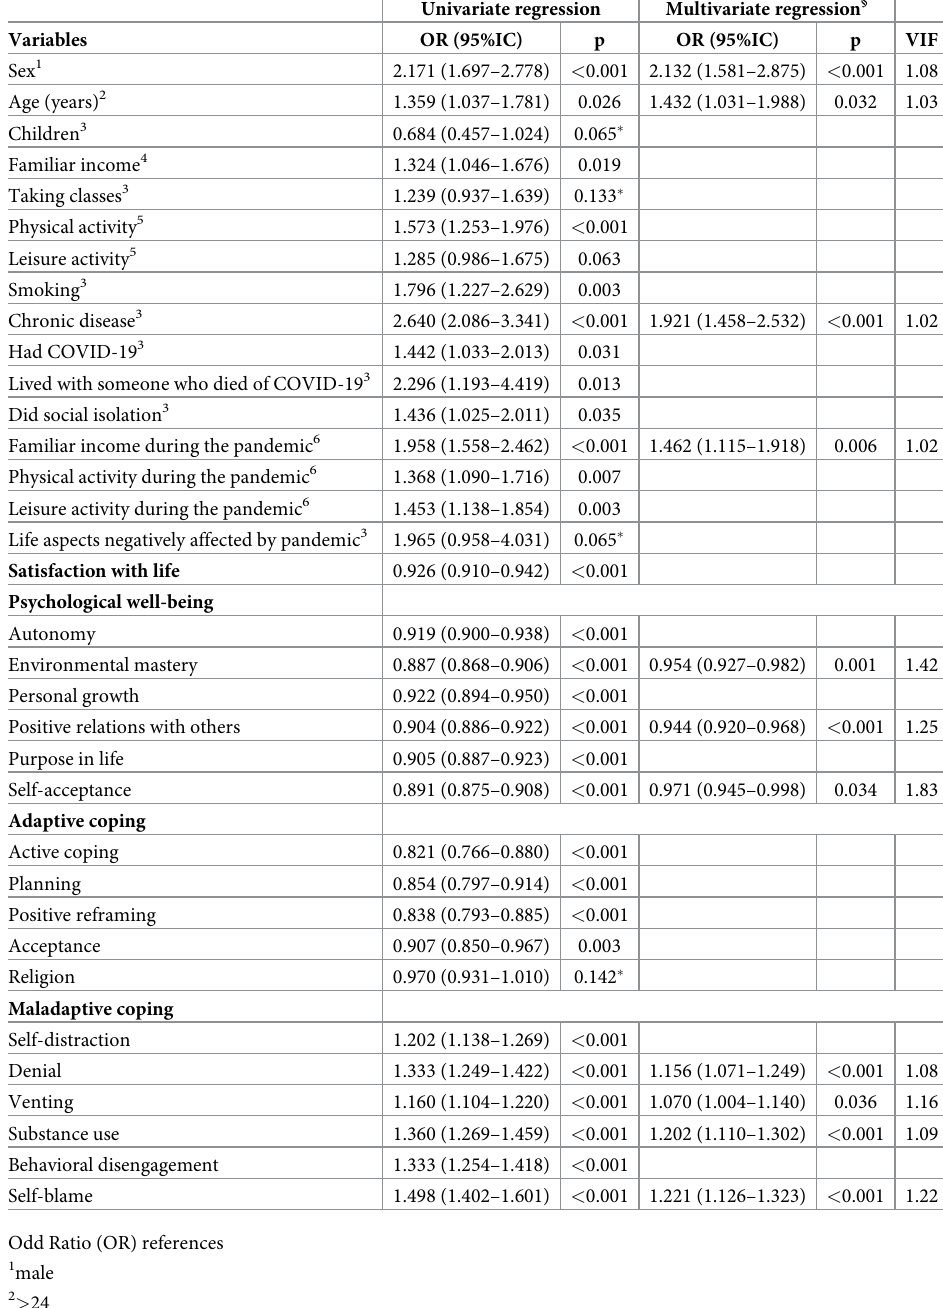
Table 6. Univariate and multivariate logistic regression of independent variables in relation to symptoms of anxi- ety in undergraduate students, Parana, Brazil,